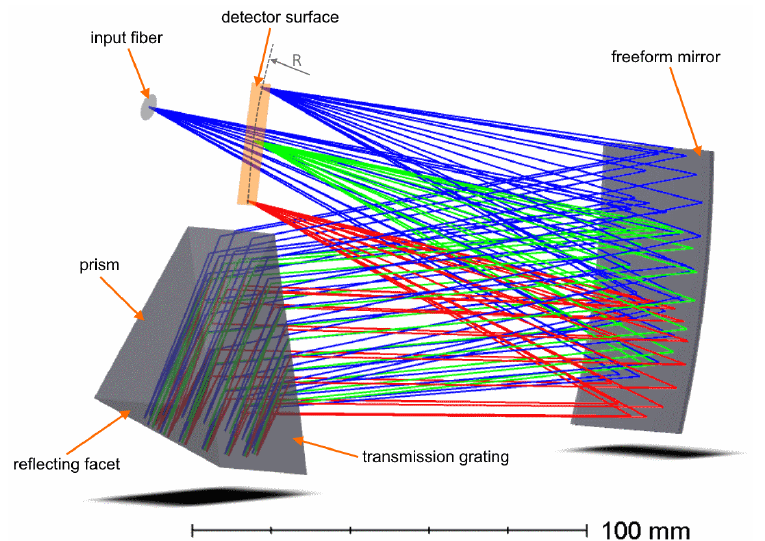
Figure 4. Optical design of the high-dispersion spectrograph with a double-pass immersed grating (Design B).